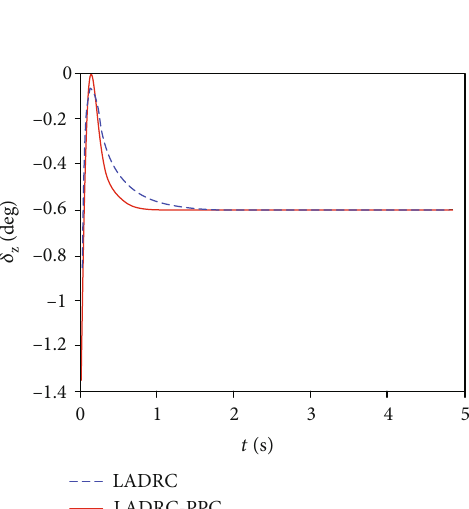
Figure 5: Pitch angular rate.